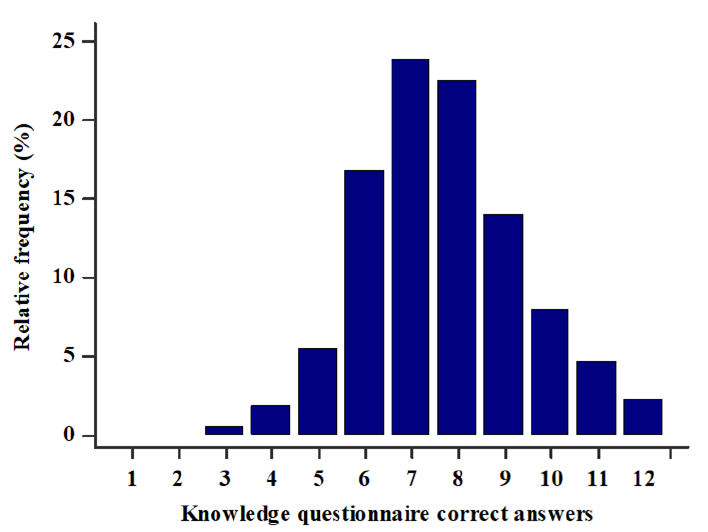
Figure 1. Knowledge questionnaire score (0–12) in the study population (N = 386).